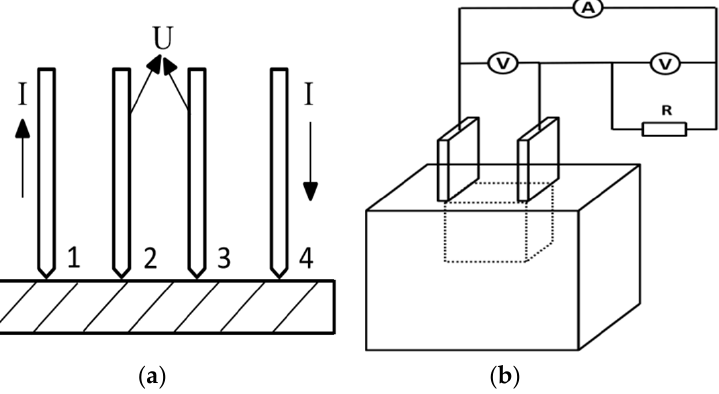
Figure 2. Test method for electrical conductivity: Four probe method ( a ), Voltmeter-ammeter method ( b ).